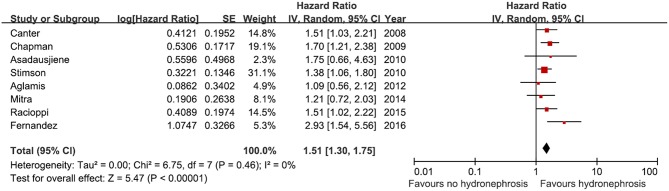
Forest plot and meta-analysis overall survival after radical cystectomy according to preoperative hydronephrosis. SE, standard error; IV, inverse variance; CI, confidence interval; df, degrees of freedom.